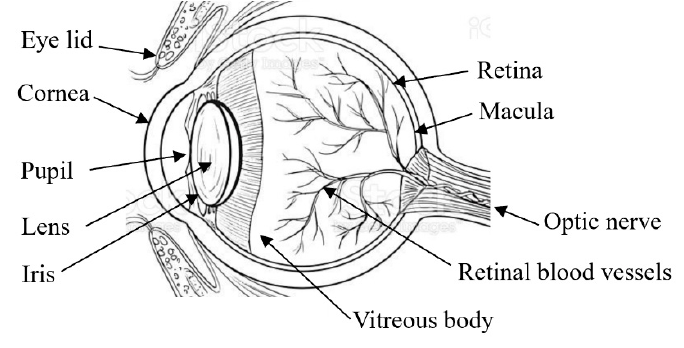
Figure 1. Anatomy of the